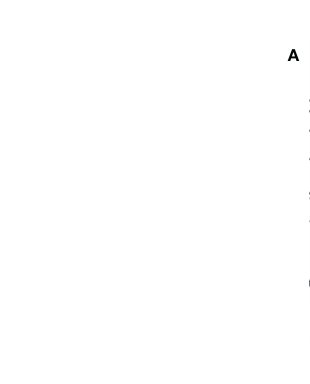
FIGURE 1 | GAL-3BP demonstrated positive correlations with MetS. (A) Serum GAL-3BP concentration. (B) Protein expressions of GAL-3BP and internal control GAPDH in Visceral Adipose Tissues. (C) Quanti fi cation of proteins with normalization to protein levels of GAPDH. Data are represented as mean ± SEM. n = 11-20, * p < 0.05 vs CD mice.